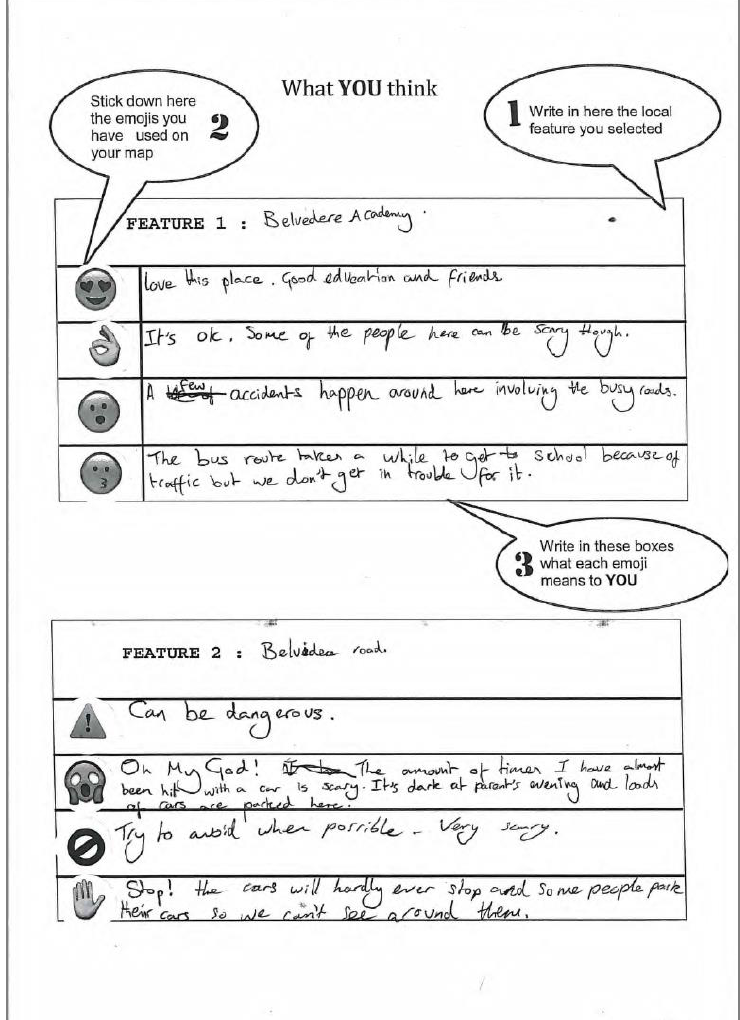
Figure 4. Example of completed emoticon table, with brief descriptions of each emoticon (not to scale). Here the partic- ipant has selected her school as being the local ‘feature’ most important for connectivity, and the local main road as that most important for separation. The participant has listed four emoticons for each feature, and written a text de- scription of each